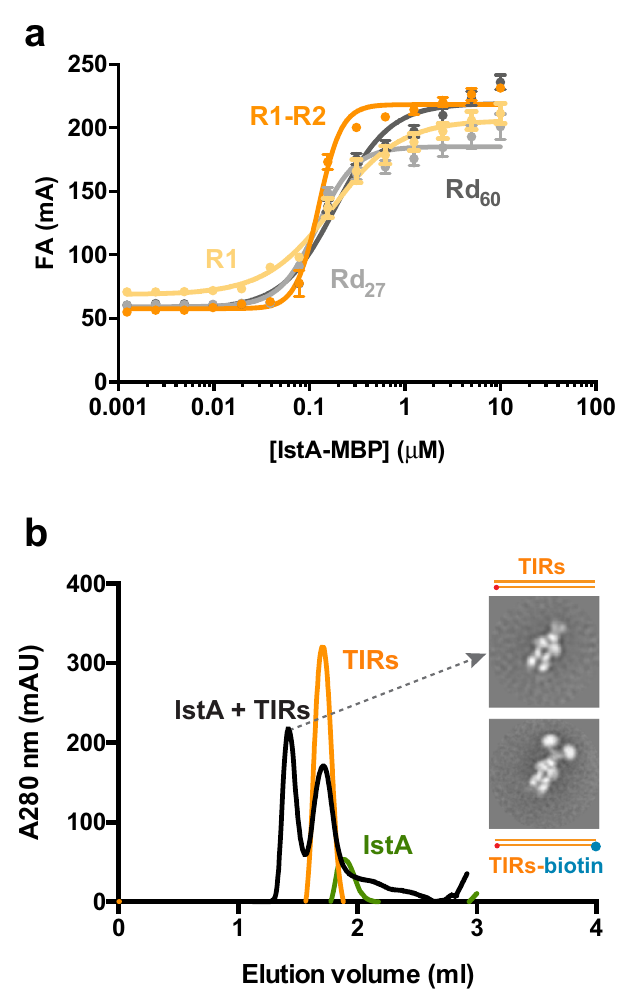
Fig.2|DNAbindingandoligomerizationbyIstA.a Effectofsequenceandlength on the DNA binding activity of IstA as measured by fl uorescence anisotropy (mA). R1-R2 (orange), pre-cleaved full right transposon end; R1 (yellow), half of the transposon end containing the fi rst direct repeat; Rd 60 (dark grey), 60bp-long randomDNA;Rd 27 (lightgrey),27bp-longrandomDNA.Datapointsanderrorbars represent the mean values and standard deviation, respectively, between six independent experiments (except Rd 60 that was performed three times). Source data are provided as a Source Data fi le. b Analytical gel fi ltration shows that DNA- free IstA elutes as a monomer but readily forms a large molecular weight complex (~250kDa) in the presence of appropriate transposon ends. Chromatogram of isolatedIstAisshownasagreenline,freeTIRsinorangeandtheIstA (cid:129) TIRscomplex inblack.Inset:Negativestain2DclassaveragesofthepeakfractionscontainingIstA in complex either with the TIRs (upper class average), or with biotin-tagged TIRs preincubatedwithstreptavidin(lowerclassaverage).Reddotindicatestheposition of the terminal CA dinucleotide that contains the donor 3 ’ -OH while the blue dot showsthepositionofthebiotintag.SourcedataareprovidedasaSourceData fi